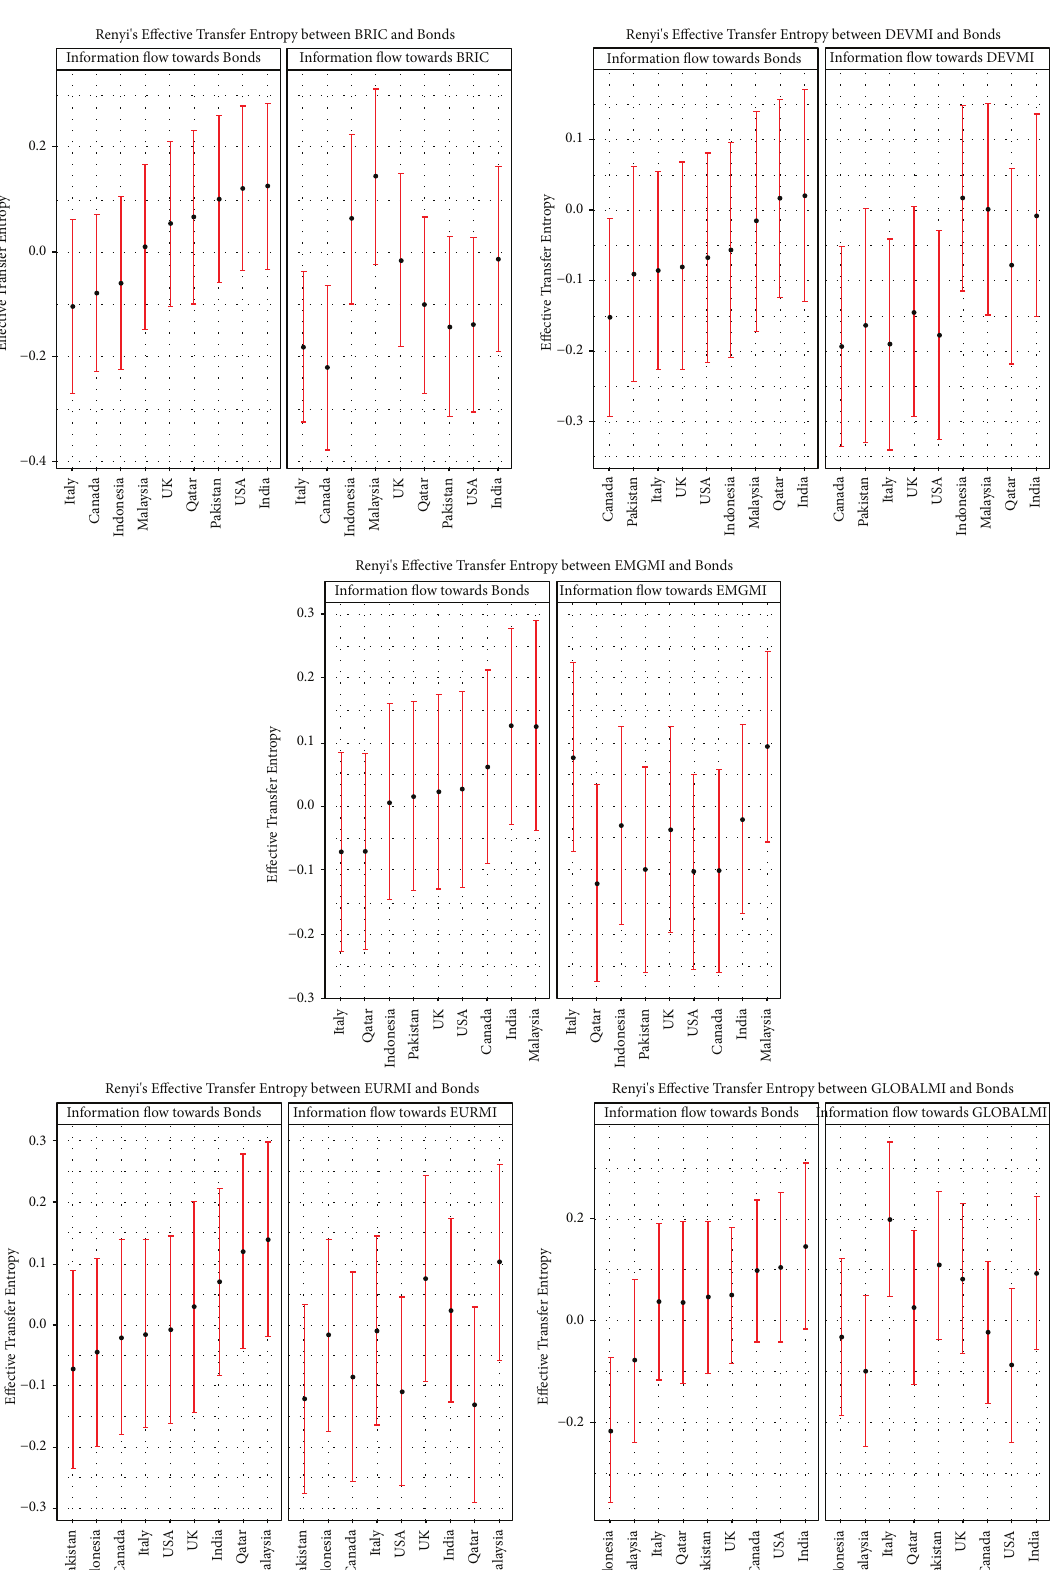
Figure 3: Transfer entropies between bonds and global equities at the composite level. (a) Renyi’s effective transfer entropy between BRIC and bonds, (b) Renyi’s effective transfer entropy between DEVMI and bonds, (c) Renyi’s effective transfer entropy between EMGMI and bonds, (d) Renyi’s effective transfer entropy between EURMI and bonds, and (e) Renyi’s effective transfer entropy between GLOBALMI and